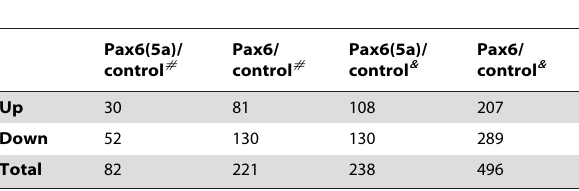
Table 1. Number of genes differentially regulated in the 3T3- Pax6 and 3T3-Pax6(5a) cell lines compared to the 3T3-control cell